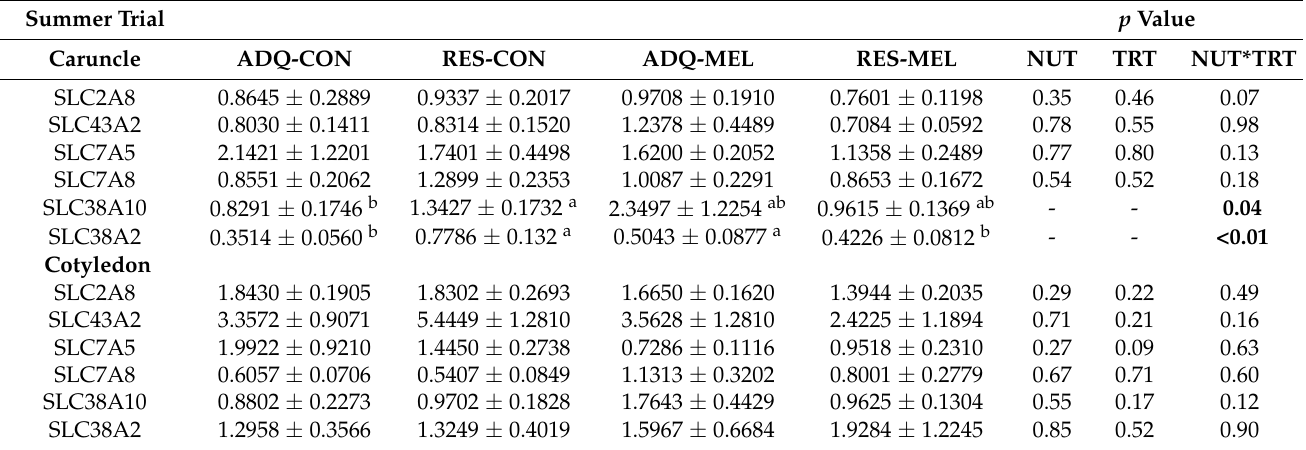
Table 5. Transcript abundance of nutrient transporters in caruncle and cotyledon tissue in the summer